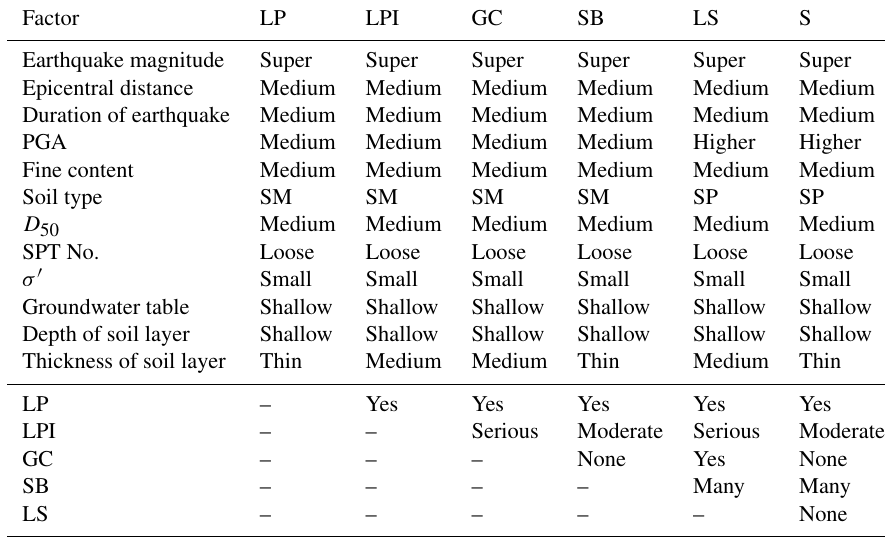
Table 7. Most probable explanation of LP, serious LPI, GC, many SB, big LS, and big S in the BN model.